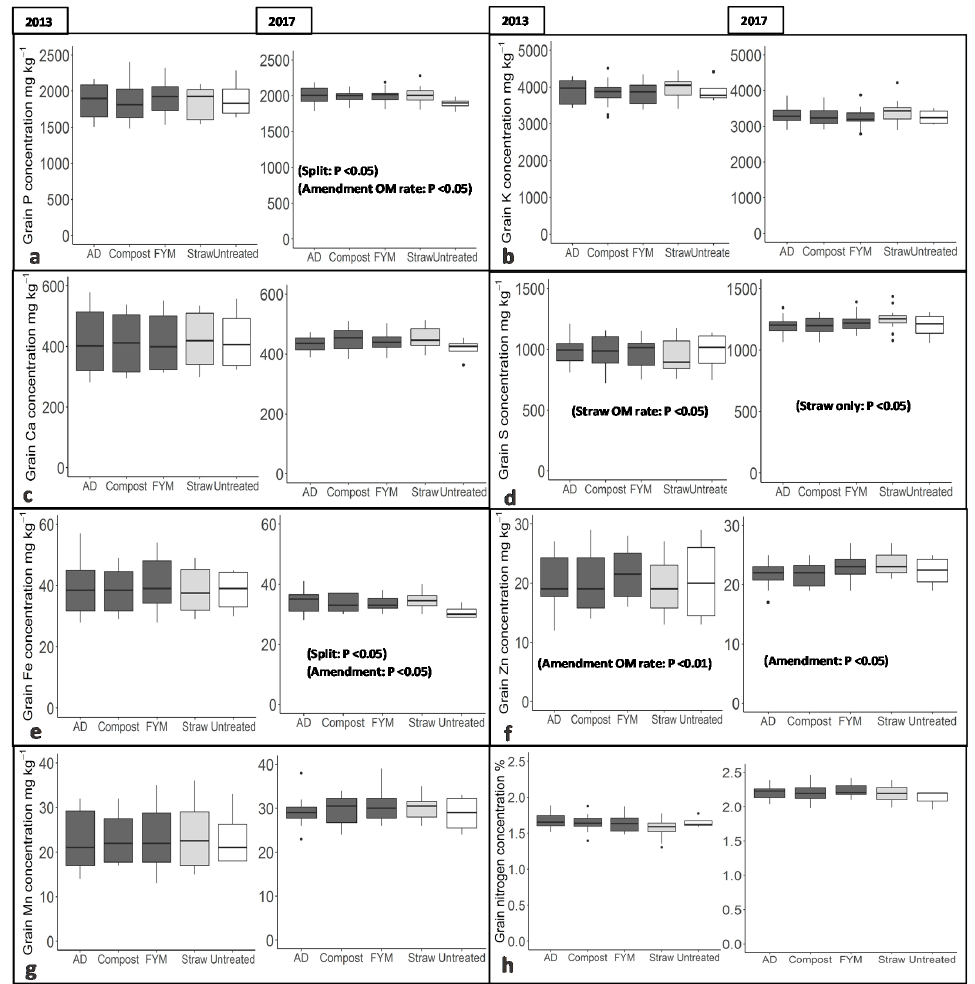
Figure 3. Median (± 25th and 75th quartiles, 95% CI and outliers) grain concentration of ( a ) phosphorus, ( b ) potassium, ( c ) calcium, ( d ) sulfur, ( e ) iron, ( f ) zinc, g. manganese, and h. nitrogen